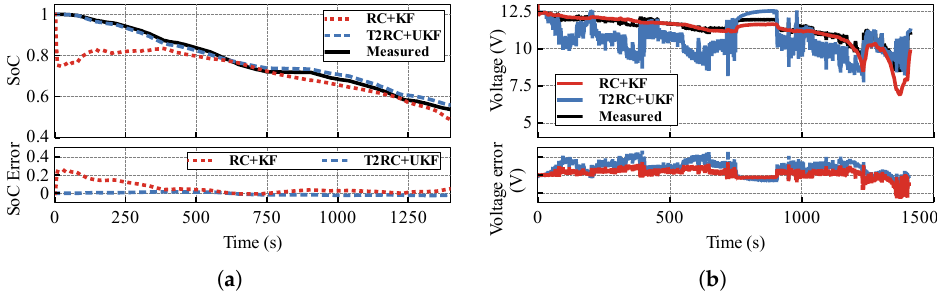
Figure 11. Method performance validation using robot operation data for the SLA battery: ( a ) SoC estimation performance of the RC model with KF (RC+KF) and the 2 RC Thevenin model with UKF (T2RC+UKF). ( b ) Comparison of battery voltage estimation performance of RC model with KF (RC+KF) and the 2 RC Thevenin model with UKF (T2RC+UKF). RC+KF T2RC+UKF